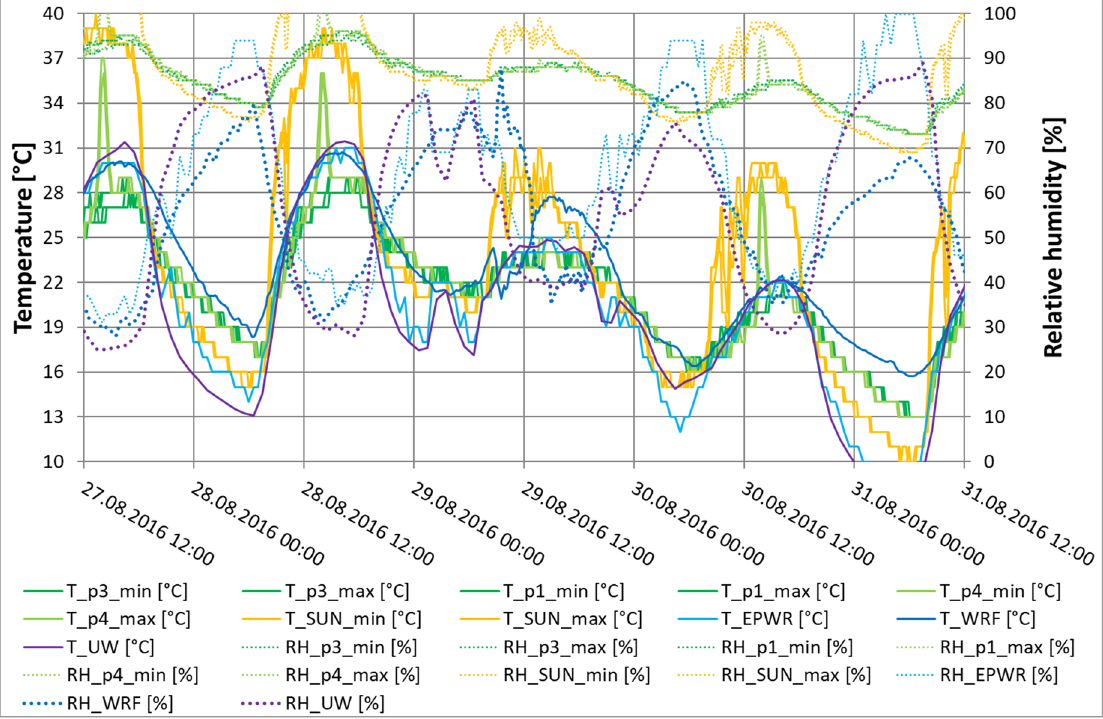
Figure 7. The results of the second temperature and humidity measurements (series B): 27 th –31 st August 2016 (12:00–12:00). Abbreviations: p1, p3, p4—shelf number (from the bottom of